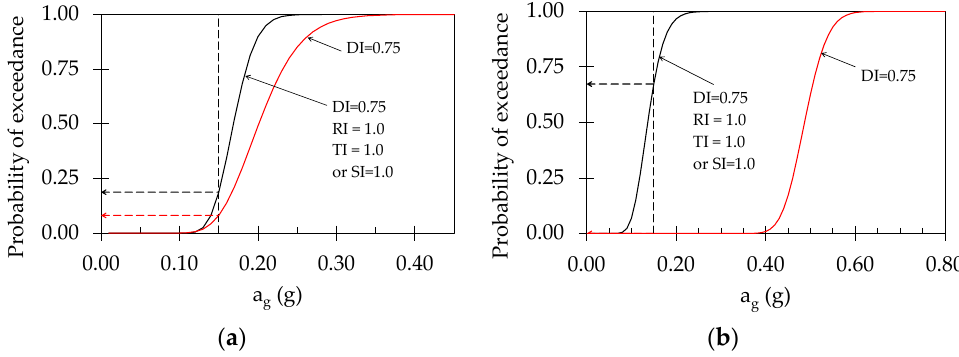
Figure 3. Fragility curves at the SD limit state of a 4-storey case study: ( a ) Q = 1.0; ( b ) Q = 2.5.